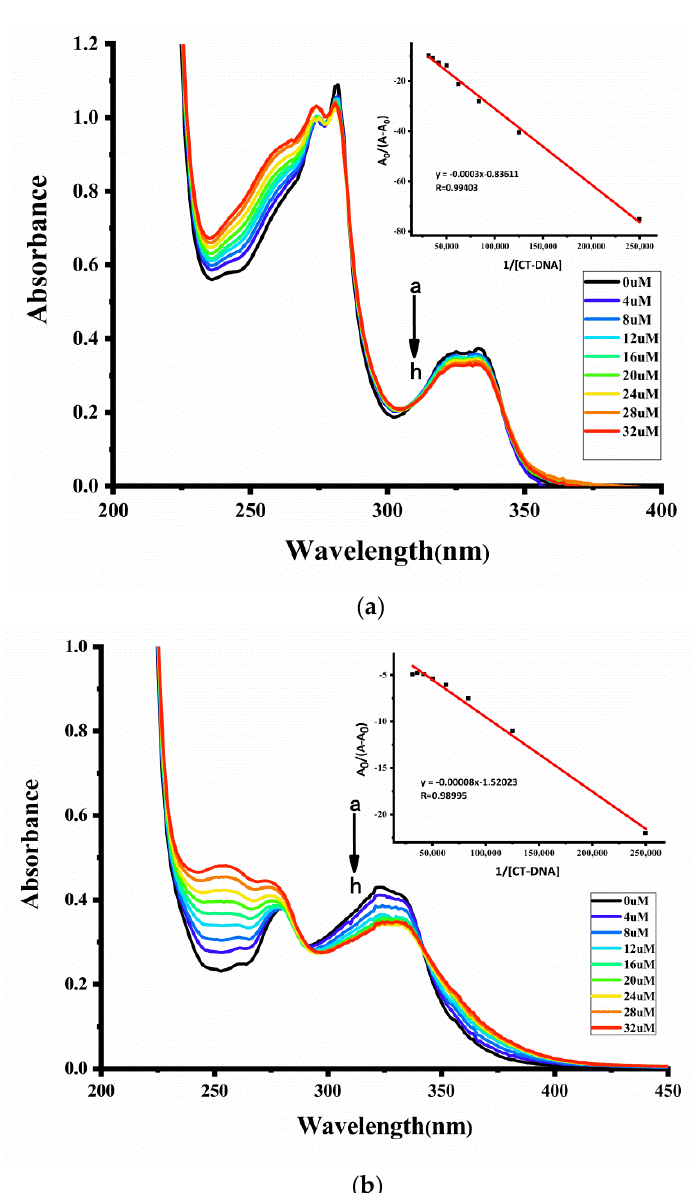
Figure 9. Absorption spectra of 20 μM of compounds ( a ) 1 and ( b ) 3 in a Tris-HCl buffer (pH = 7.2) solution with series concentrations of CT-DNA. The plots of A 0 /(A − A 0 ) versus the concentration of CT-DNA are shown as the insets.